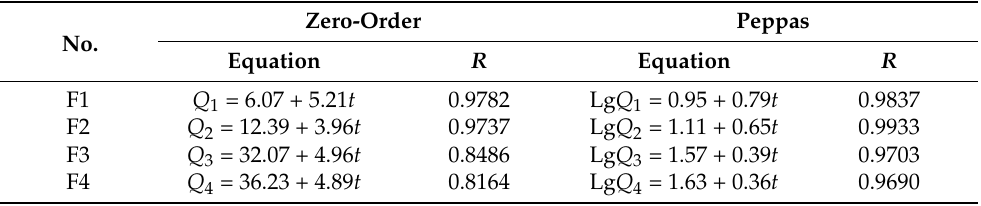
Figure 8. In vitro drug dissolution results: ( a ) drug release profiles of fibers F1 and F2 according to time; ( b ) the time needed for releasing a certain content of MET from fibers F1 and F2; ( c ) drug release profiles of fibers F3 and F4 according to time; ( d ) the time needed for releasing a certain content of MET from fibers F3 and F4. Table 2. Kinetics of the drug release regressed according to the zero-order and Peppas models.